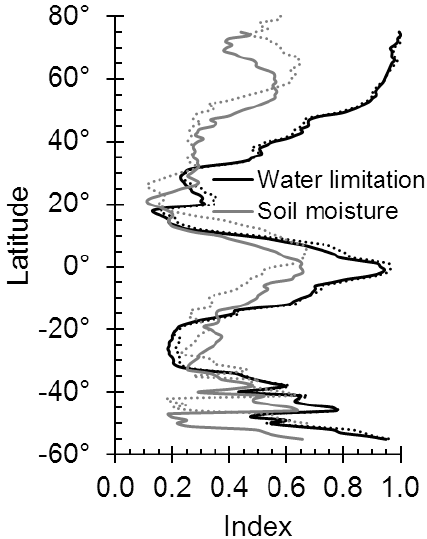
Fig. 1. Latitudinal pattern of soil moisture and NPP water limi- tation, presently (1971–2000 averages; solid lines) and in the fu- ture (2071–2100; dotted lines), simulated with the LPJ DGVM for potential natural vegetation. Future changes are the medians ob- tained under climate change scenarios from five General Circula- tion Models (SRES A2 emissions), including direct CO 2 effects on plants. Both variables are plotted as indices scaled between 0 and 1: soil moisture relative to maximum water holding capacity (0=dry), water limitation relative to potential canopy conductance attainable under water-unlimited conditions (0=completely water- limited). Modified after Gerten et al. (2005,